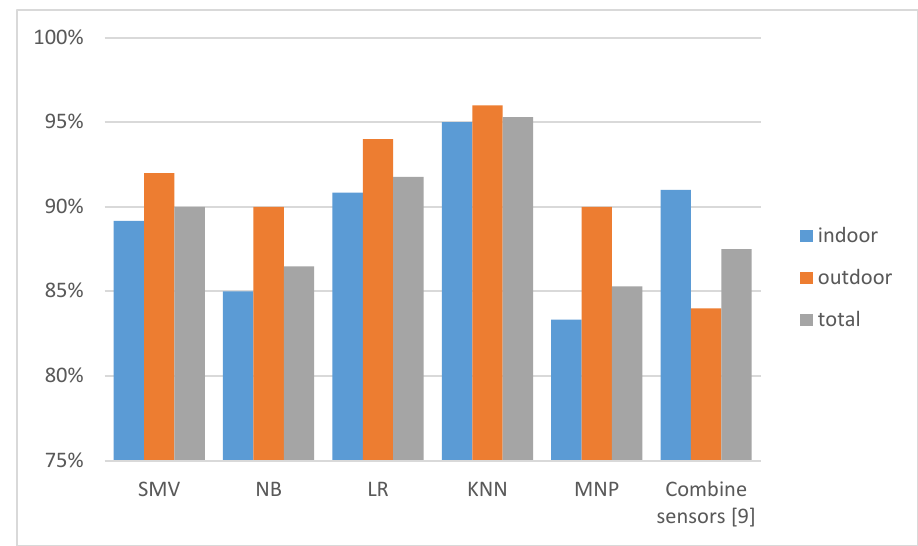
Figure 12. Accuracy of I / O detection with semi-indoor samples (classified as indoor samples).